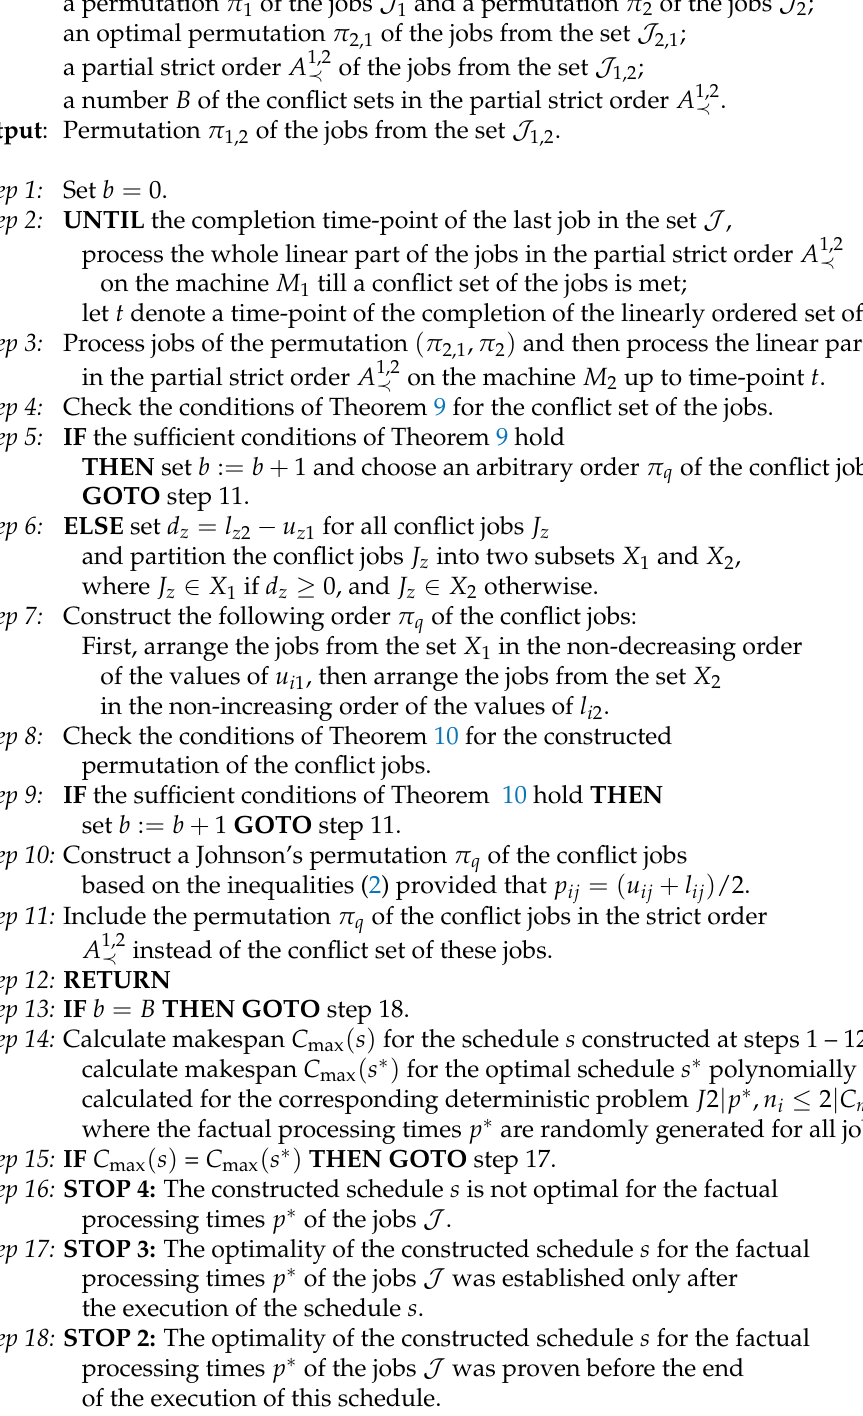
Algorithm 3 for the on-line phase of